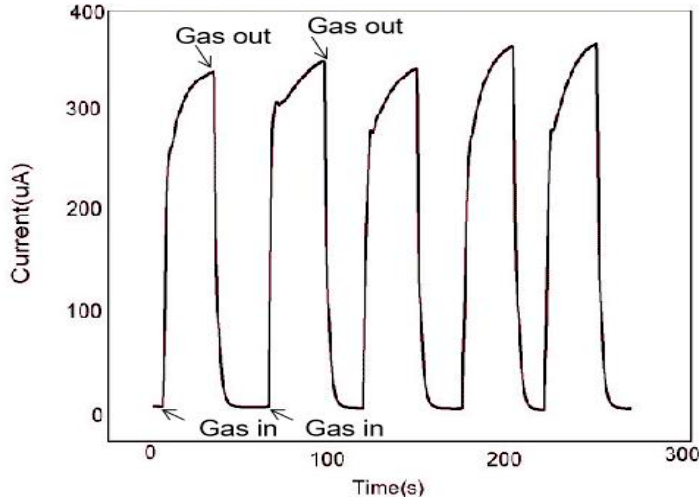
Figure 9. At 270 °C, five consecutive measurements of the In 2 O 3 -8 h sensor for 100 ppm ethanol.